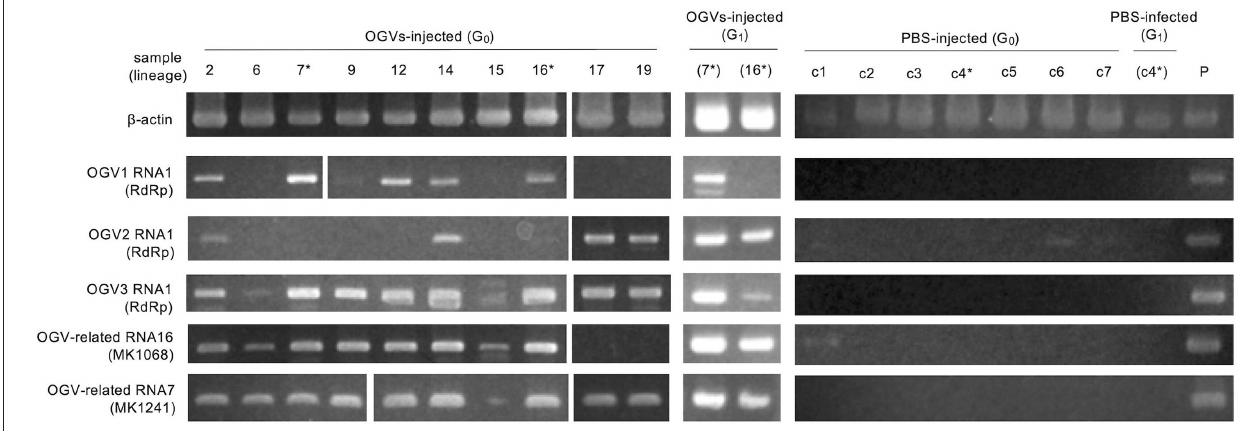
FIGURE 3 | Injection of purified Osugoroshi virus (OGV) virions into the Homona magnanima non-biased sex ratio (NSR) strain. RT-PCR confirmed OGV infection. Fourth instar larvae of H. magnanima NSR-TYO strain were injected with purified OGVs or phosphate-buffered saline (PBS), and total RNA was extracted from 10 adult female moths (G 0 ). G 1 adult females were generated from the G 0 females (asterisks) by mating with NSR males. The total RNA from adult females of the laboratory-maintained late strain was used as a positive control (P). *shows the linage relationships.